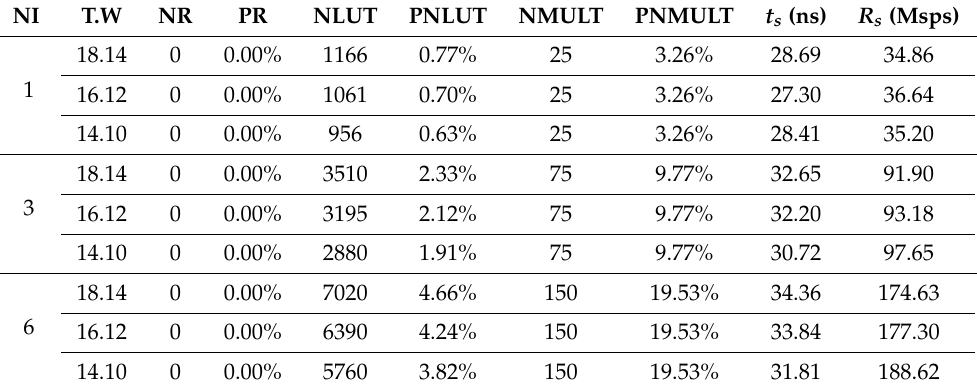
Table 7. Synthesis results regarding the hardware area occupation, processing time, and throughput for the MLP module implemented without the BP and varying NI and the number of bits.